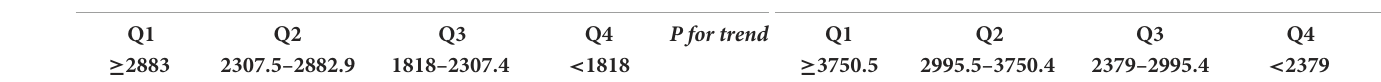
TABLE 3.3 Associations of FEV1 and FVC with cancer mortality in U.S. adults aged at least 20 years among different groups. FEV1